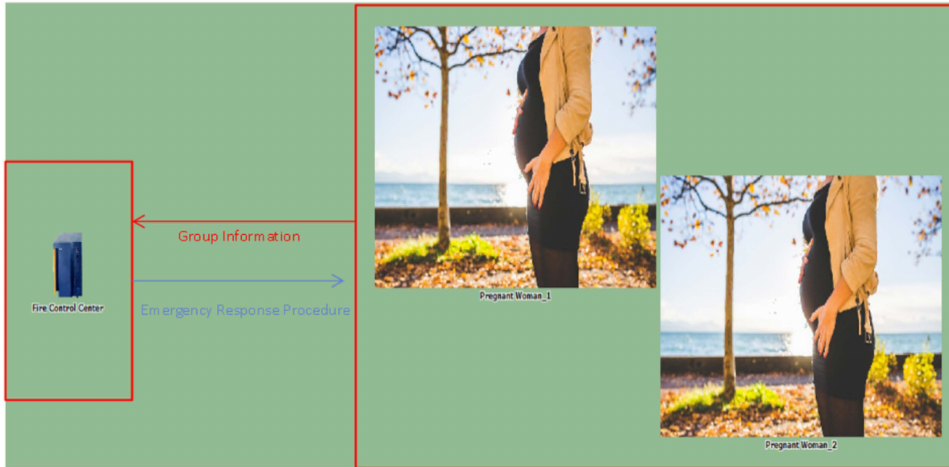
Figure 15. Information communication for reinforcing safety education for fire